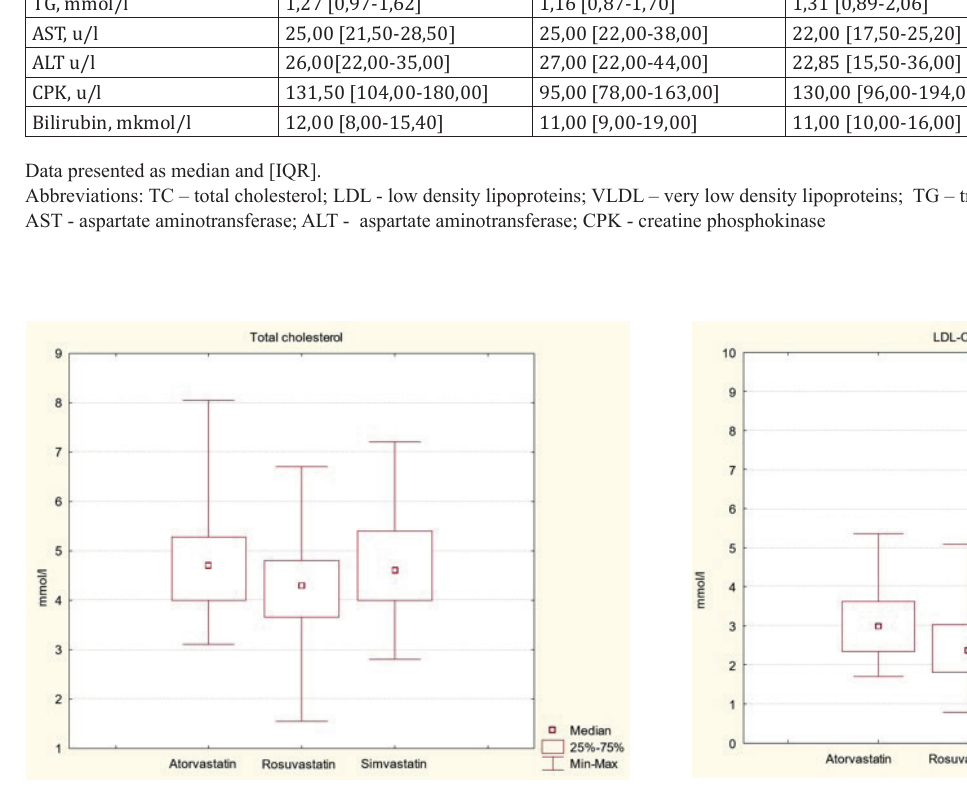
Figure 1 - Group differences in the level of total cholesterol depending on the choice of statin.